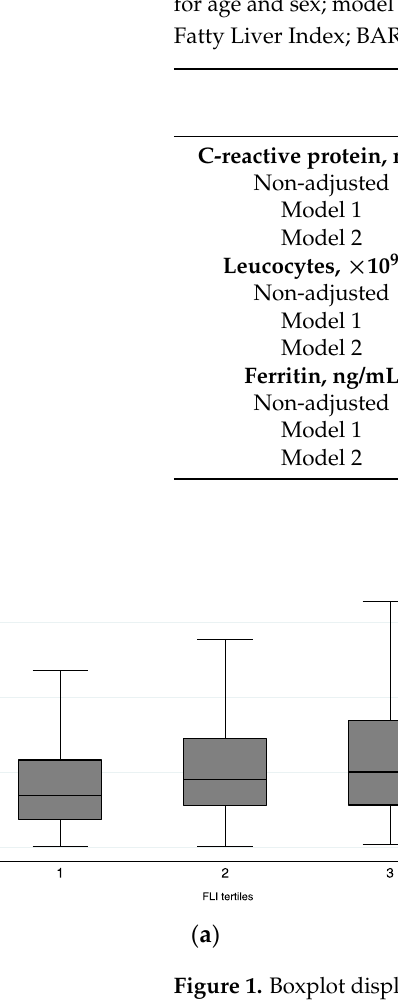
Table 4. Final regression model after stepwise approach (FLI predictors). Abbreviations: FLI, Fatty Liver